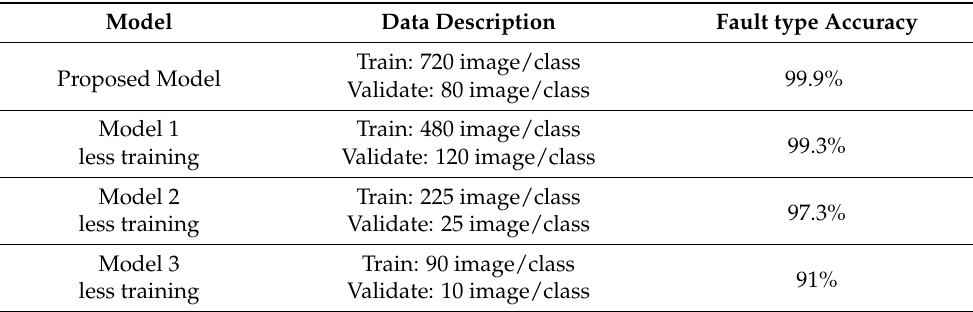
Figure 7. Confusion matrix when build model less training data. Table 4. Performance evaluations with different data